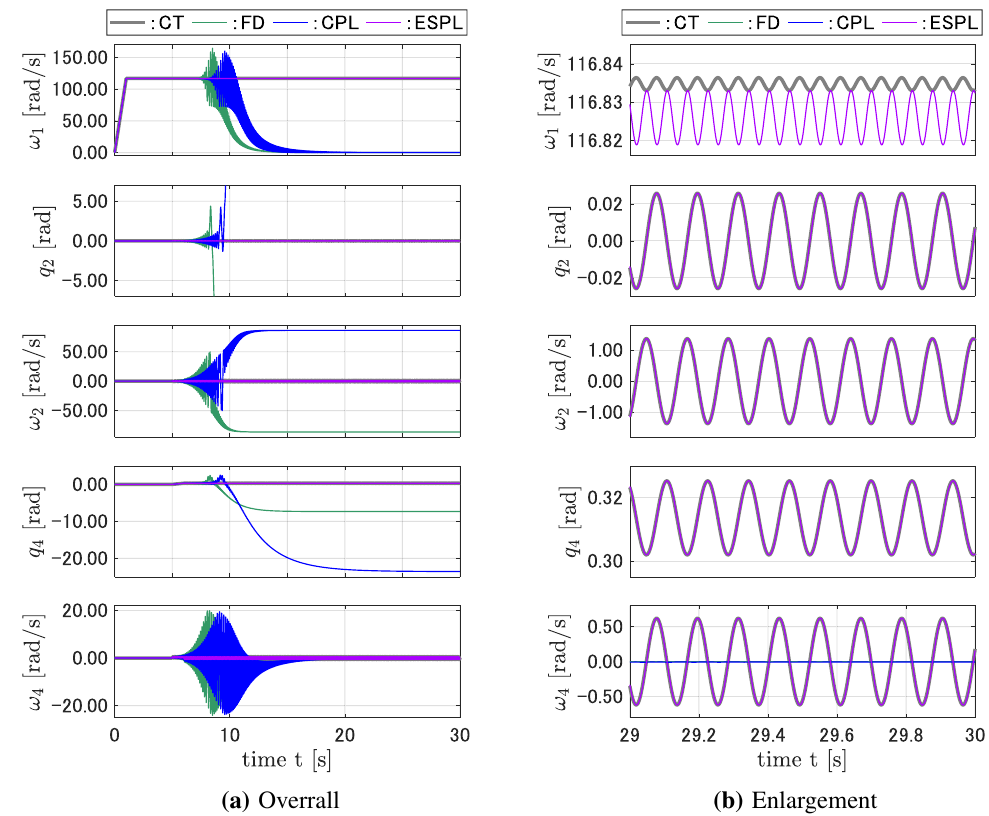
Figure 6. Responses of the CT, FD, CPL, and ESPL models for case